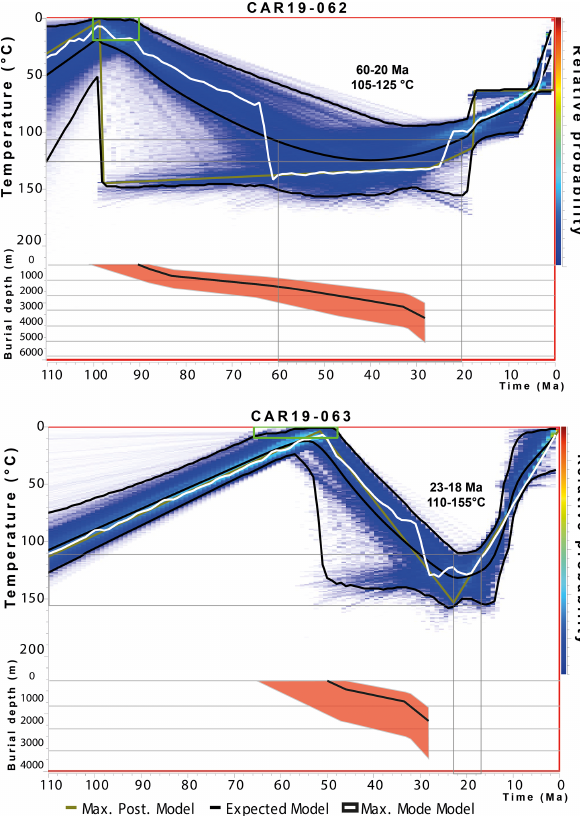
Figure 6. Modeled thermal histories and associated burial diagrams for samples CAR19-061 and CAR19-066 from the Marmarosh and Magura nappes, respectively. For sample CAR19-061, burial dia- grams are shown for both the stratigraphy from the Ukrainian geo- logical map (orange) and the revised stratigraphy proposed by Os- zczypko et al. (2005; green) as shown in Fig. 2. Peak burial temper- ature and time are highlighted by grey boxes.